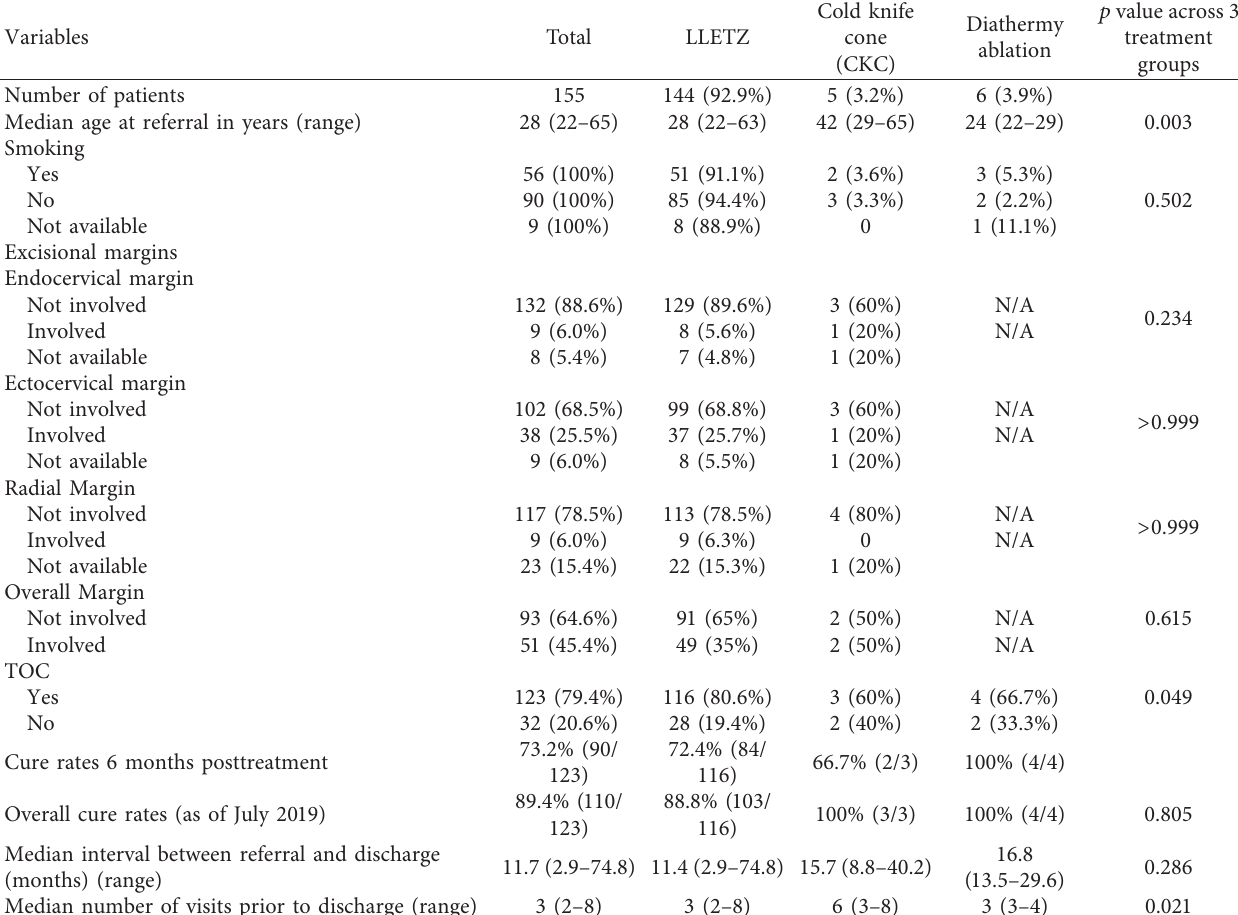
Table 3: Summary of characteristics of initial excision